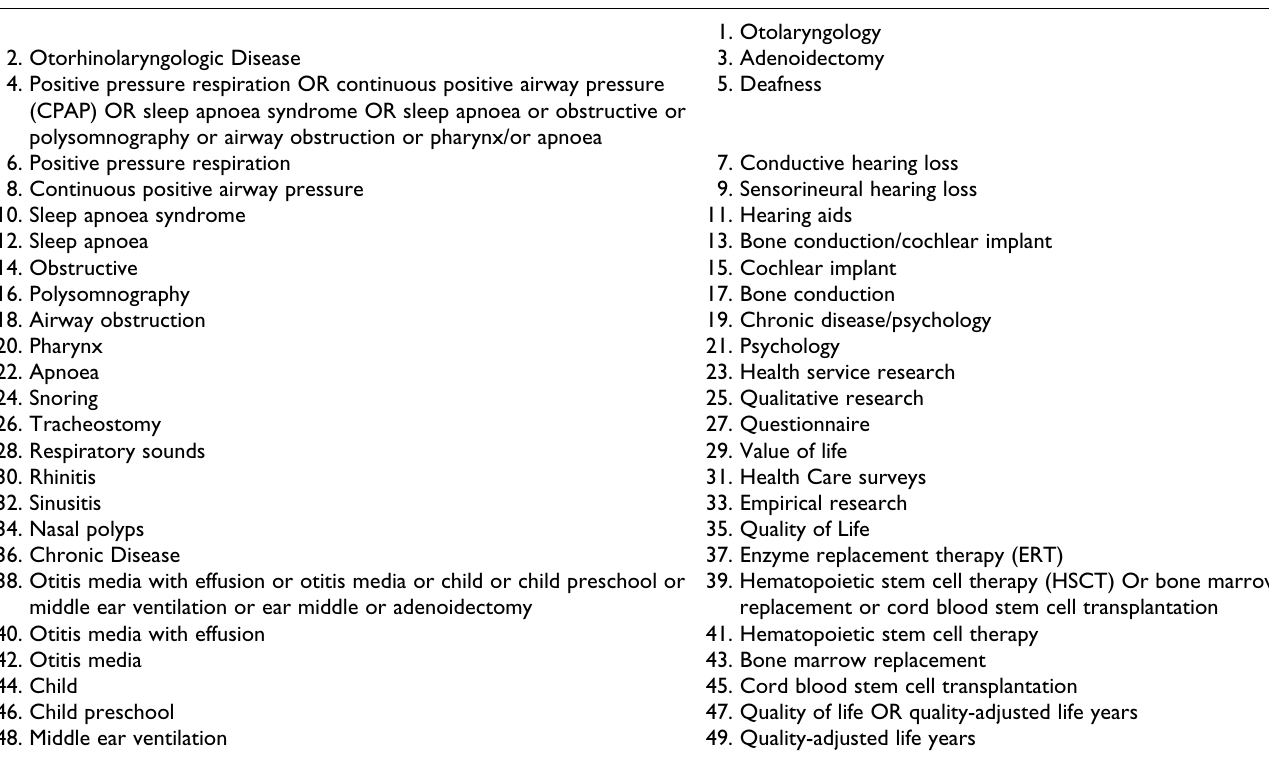
Table 1. MeSH headings for systematic review